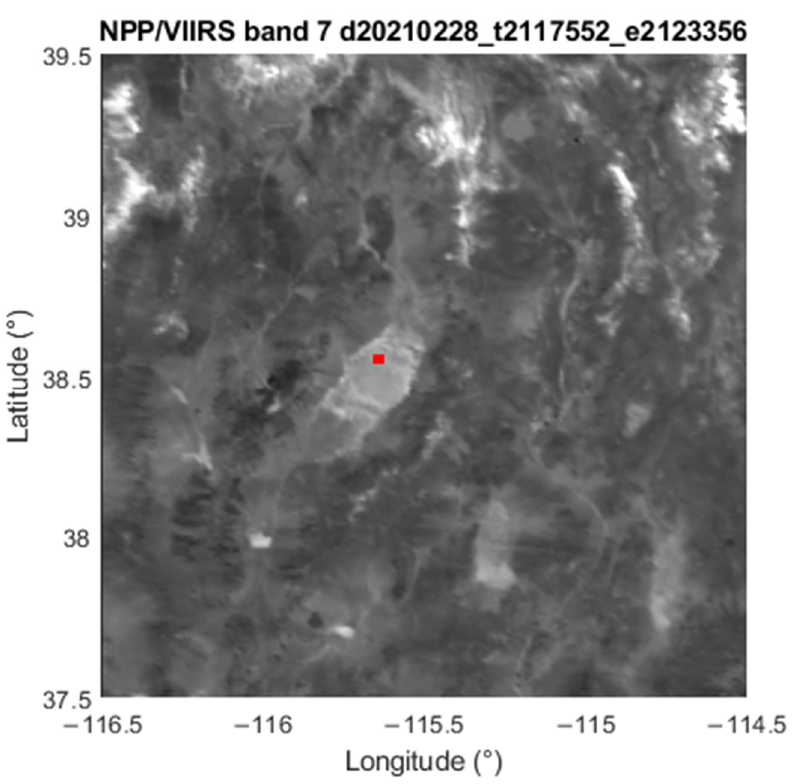
Figure 1. 28 February 2021 SNPP/VIIRS band 7 image in RVUS. The red square indicates the effective range of ground-based spectral measurements.